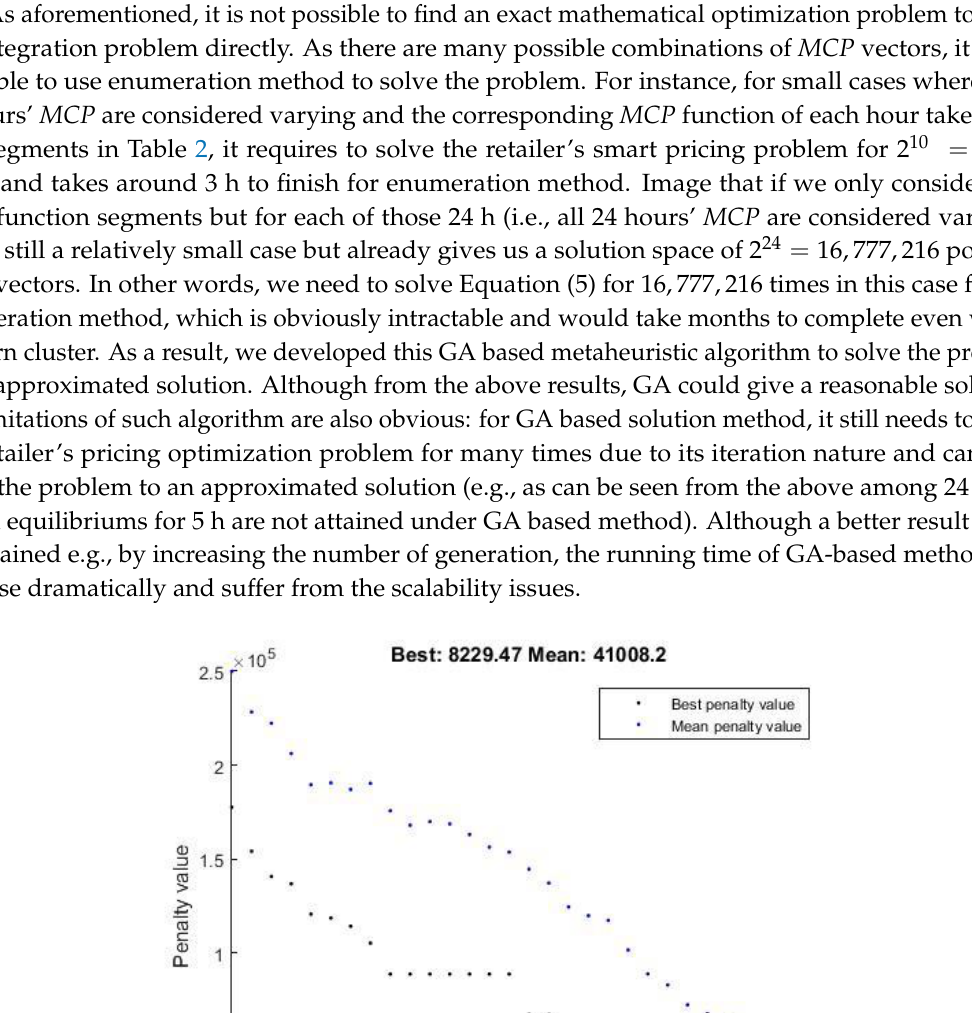
Figure 8. The customers’ demand and 𝑧 ℎ .